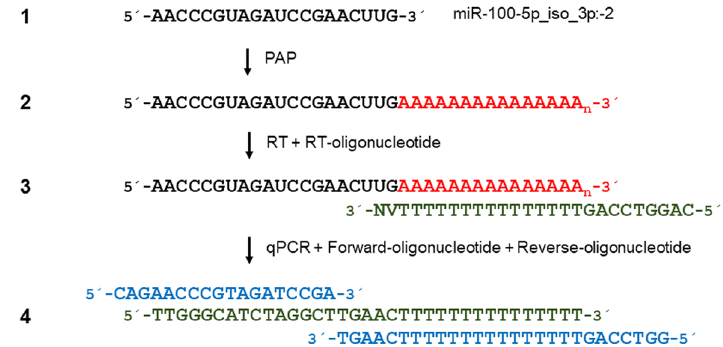
Figure 2. Schematic description of miR-specific RT-qPCR for miR-100-5p_iso_3p:−2 detection. This method uses SYBR Green detection chemistry and a single reverse transcription reaction for all miRs combined with real-time PCR with two miR-specific DNA oligonucleotides. Purified RNA containing miRs (1) is polyadenylated with adenosine and poly adenosine polymerase (PAP) (2), polyadenylated RNA is reverse transcribed with RT and an anchored poly deoxythymidine oligonucleotide (3), and the generated cDNA is then subjected to qPCR with two tagged, specific oligonucleotides (miR-100-5p_iso_3p:−2) (4).